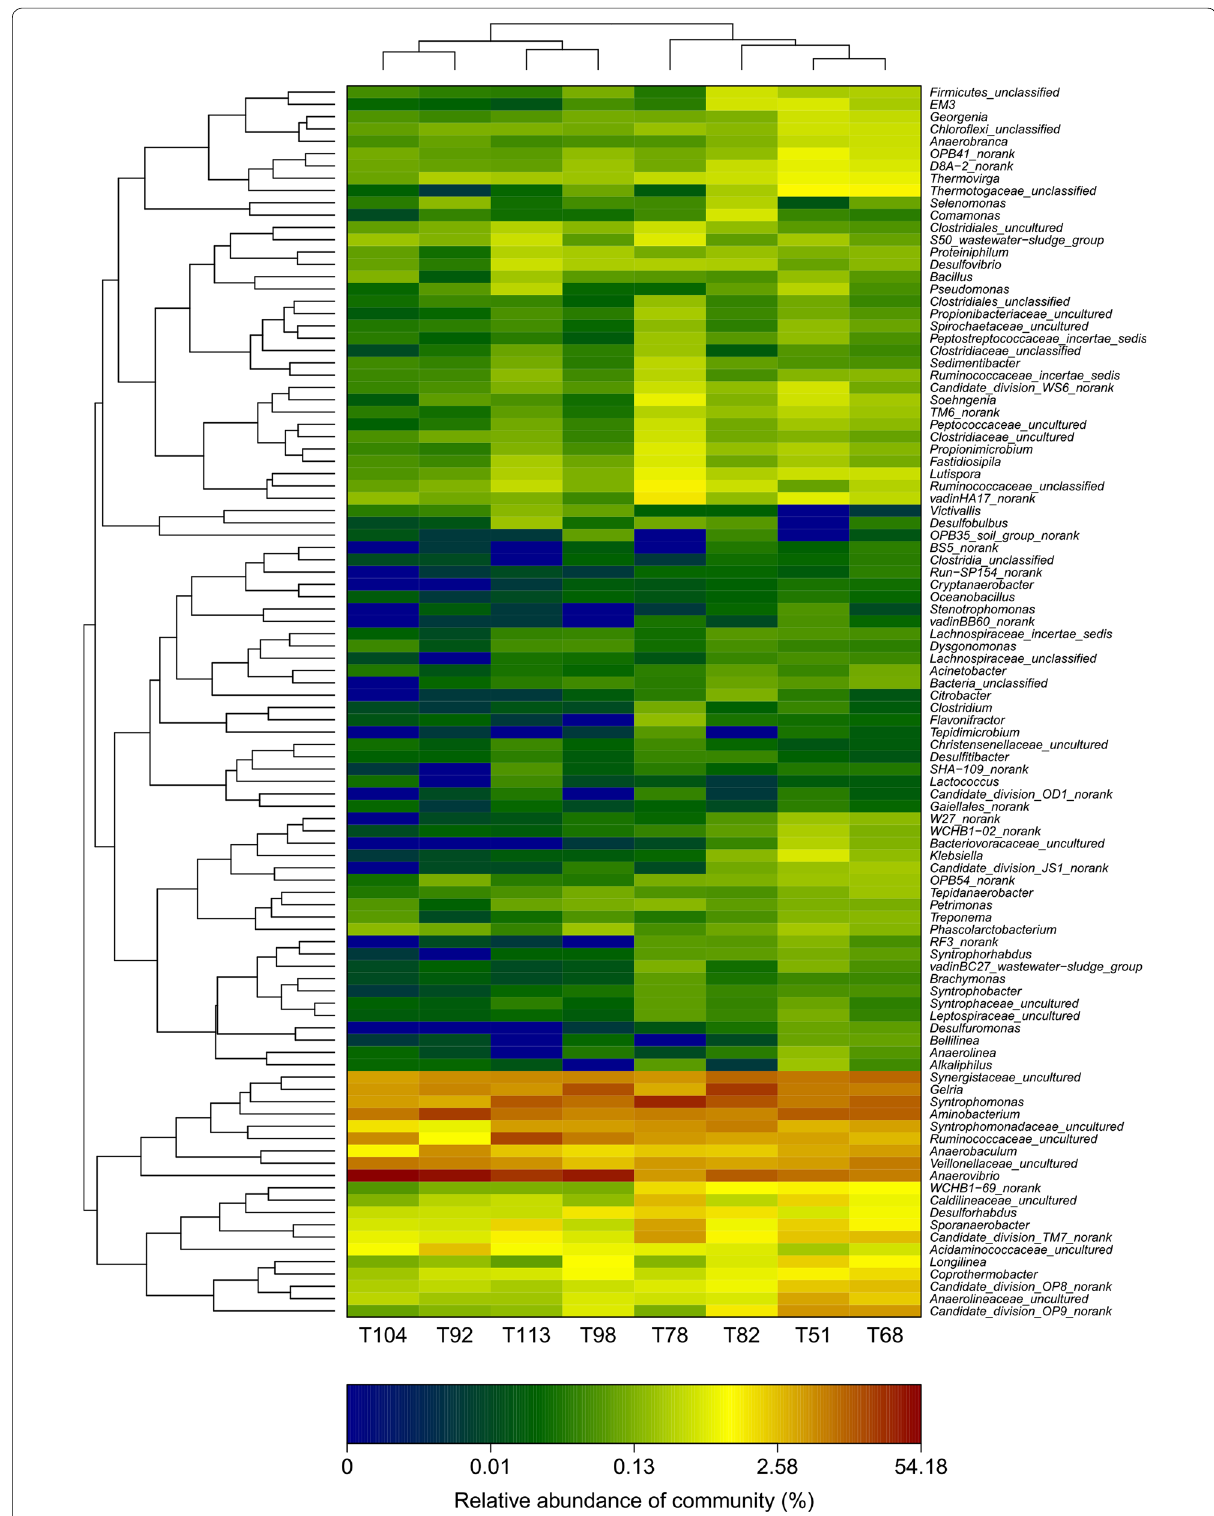
Fig. 3 Hierarchical cluster analysis of microbial communities among the 8 samples. The Y‑axis is the clustering of the top 100 abundant genus. Different samples were clustered based on complete linkage